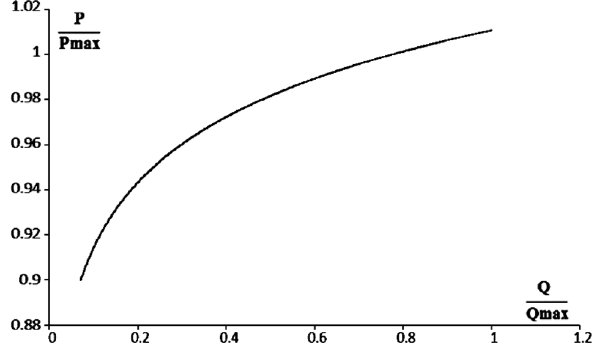
Fig. 5 Wetted perimeter discharge changes based on the Wetted- Perimeter method for one of the sections in the Qarasu